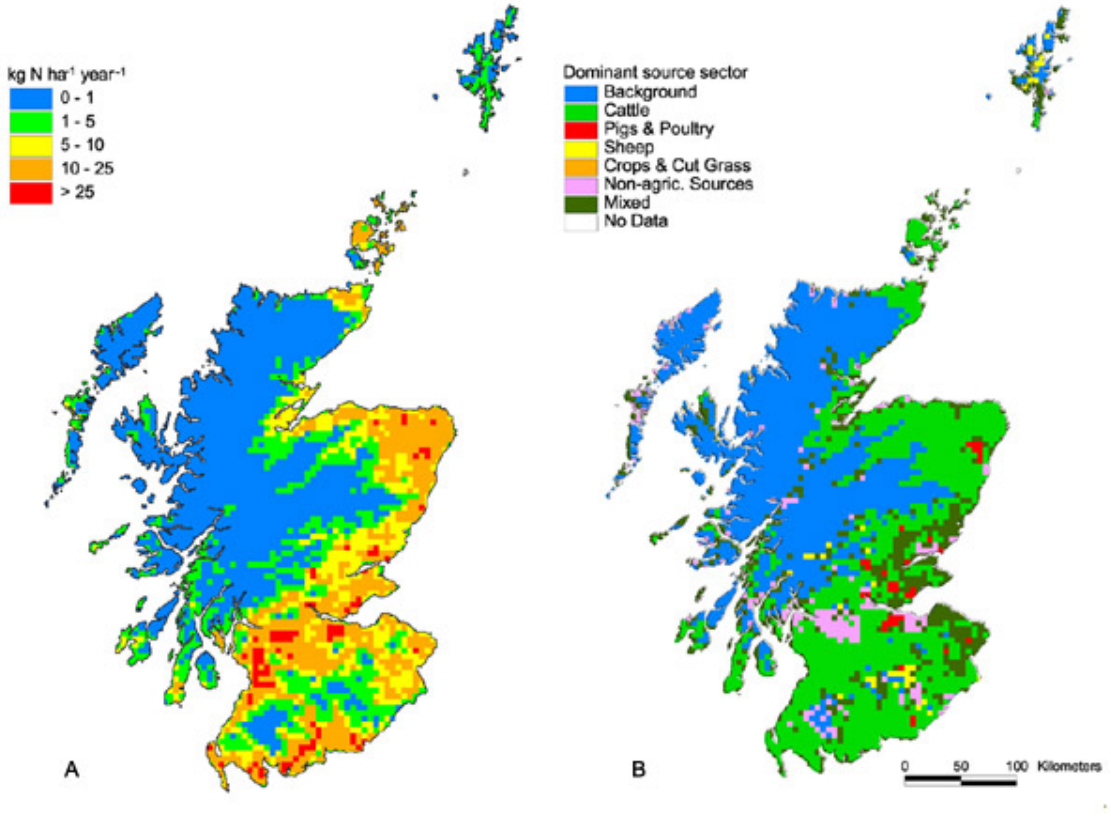
FIGURE 5. Estimated distribution of ammonia emissions for 1999 (A, left) and the main contributing sources (B, right) across Scotland (for 1988; see text for explanation of different year). In map B, “background” indicates that emissions are less than 1 kg N ha –1 year –1 averaged over a 5-km grid square. Mixed indicates that no single sector provides ≥ 45% of the total NH 3